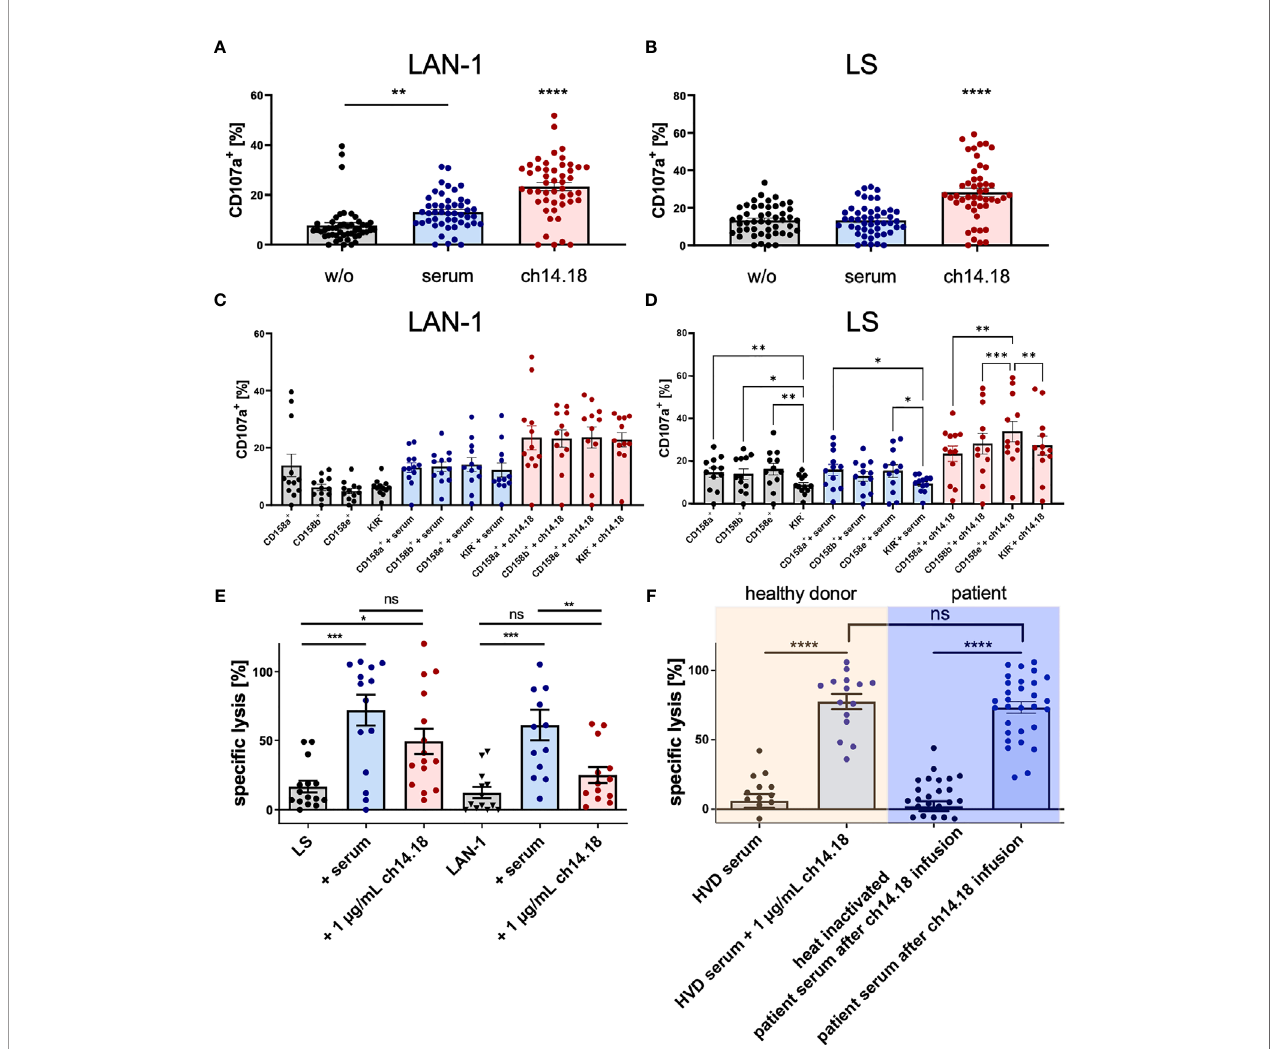
FIGURE 4 | Degranulation of patient NK cells and cytolysis mediated by ch14.18/CHO. Patient PBMCs acquired post haploidentical HSCT were used to test the capacity of degranulation, measuring CD107a (LAMP-1) expression as a strong indicator of NK cell activation and cytolysis targeting the neuroblastoma cell lines LAN-1 and LS in a 6 h fl ow cytometry based kill assay (A – D) . Besides testing the overall degranulation capacity, NK cell subsets distinguished by the major inhibitory killer cell immunoglobulin-like receptors (KIR) CD158a/KIR2DL1, CD159b/KIR2DL2 and CD158e/KIR3DL1 were analyzed for interpopulation differences in CD107a positivity and were evaluated in the context of the KIR receptor ligand model. Additionally, a 2 h-DELFIA-EuTDA release cytotoxicity assay was used to evaluate the cytolysis of tumor cells by patient PBMCs via ADCC and CDC (E, F) . The testing conditions (E) comprised I) PBMCs versus tumor, II) PBMCs versus tumor and patient serum (after infusion of ch14.18/CHO), and III) PBMCs versus tumor and 1 µg/ml ch14.18/CHO. Moreover, cytolysis of the neuroblastoma cell line LAN-1 by PBMCs from healthy volunteer donors (HVDs) compared to patient PBMCs was assessed. (F) The comparison included the conditions I) [HVD PBMCs plus HVD serum] versus tumor, II) [HVD PBMCs plus HVD serum plus 1 µg/ml ch14.18/CHO] versus tumor, III) [patient PBMCs plus heat inactivated patient serum] versus tumor, and IV) [patient PBMCs plus patient serum] versus tumor. Data shown in (A – D) represent mean of (n = 12) independent experiments and different donors in triplicates, respectively. Data shown in (E) represent mean of (n LAN-1 = 15; n LS = 13) and (F) represent single values of (n HVD = 5; n patients = 10) independent experiments and different donors in triplicates, respectively. Statistical signi fi cance was determined by one-way ANOVA and Tukey post-hoc test. P-values below 0.05 were de fi ned signi fi cant. * = <0.05, ** = <0.01, *** = <0.0001, **** = <0.0001. ns, not signi fi